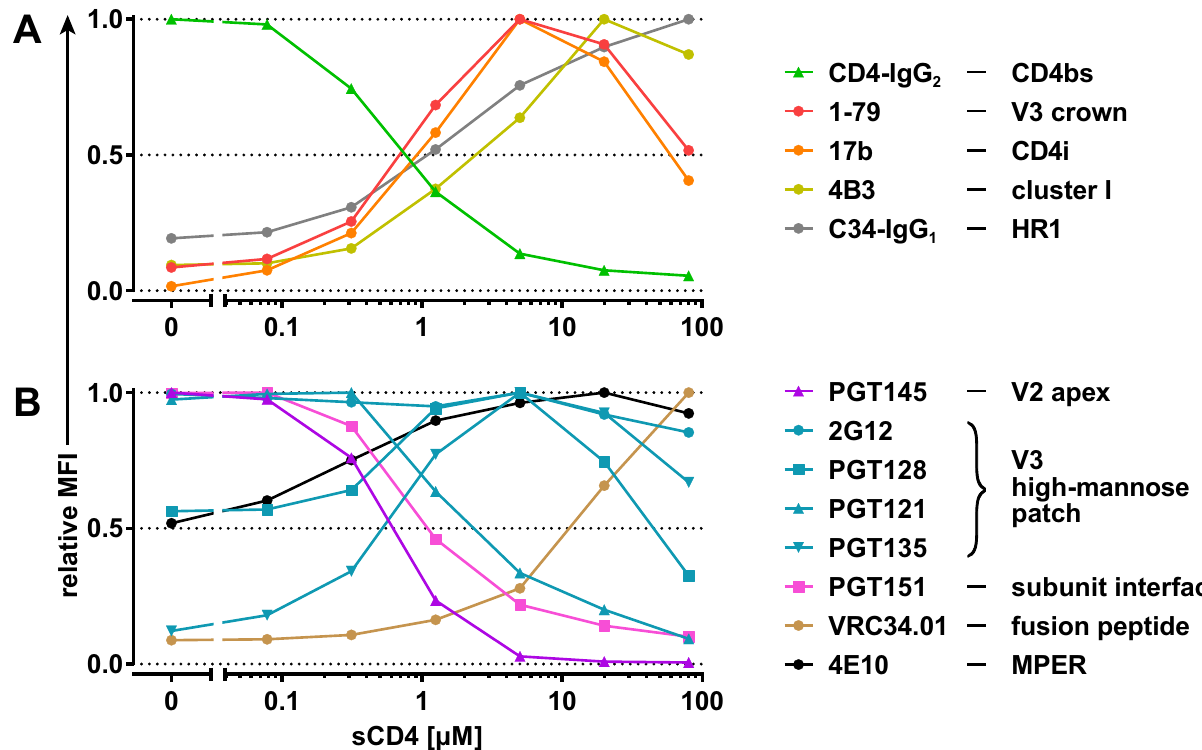
Fig 3. BaL.01 Env basal epitope exposure curves of mAbs and inhibitors. On-cell sCD4 triggering of BaL.01 Env with a 20-minute triggering step. Basal epitope exposure curves for wnAbs/nnAbs, CD4-IgG 2 , and C34-IgG 1 depicted in (A) and bnAbs depicted in (B) were selected from the relative MFI staining curves of each individual antibody/inhibitor (S3 Fig) based on the following criteria: lowest concentration of the tested antibody/inhibitor that yields at least a 10-fold-higher MFI signal over MuLV background at the peak. Histogram plots of the event distributions underlying the basal epitope exposure curves are depicted in S4 Fig. bnAb, broadly neutralizing antibody; CD4bs, CD4 binding site; CD4i, CD4-induced site; Env, envelope glycoprotein; HR1, heptad repeat 1; mAb, monoclonal antibody; MFI, mean of fluorescence intensity; MPER, membrane-proximal external region; MuLV, murine leukemia virus; nnAb, nonneutralizing antibody; sCD4, soluble CD4; V2, second hypervariable; V3, third hypervariable; wnAb, weakly neutralizing